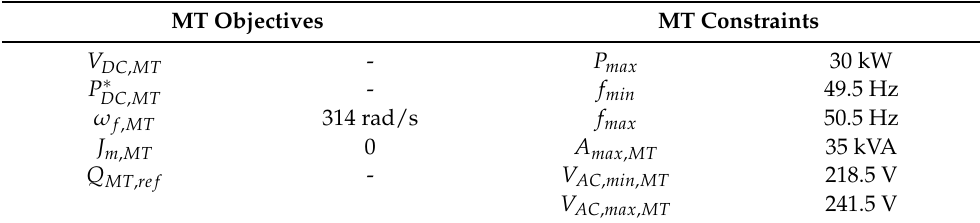
Table 4. MT Controller parameters. Slack